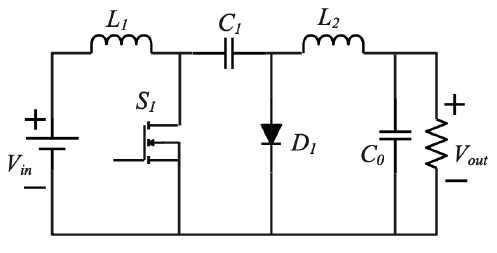
Figure 3. Basic CUK